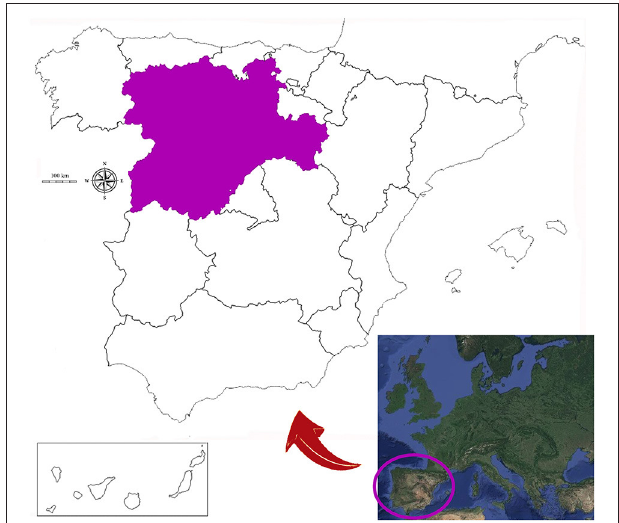
FIGURE 1 | Location of Autonomous Community of Castilla y León,